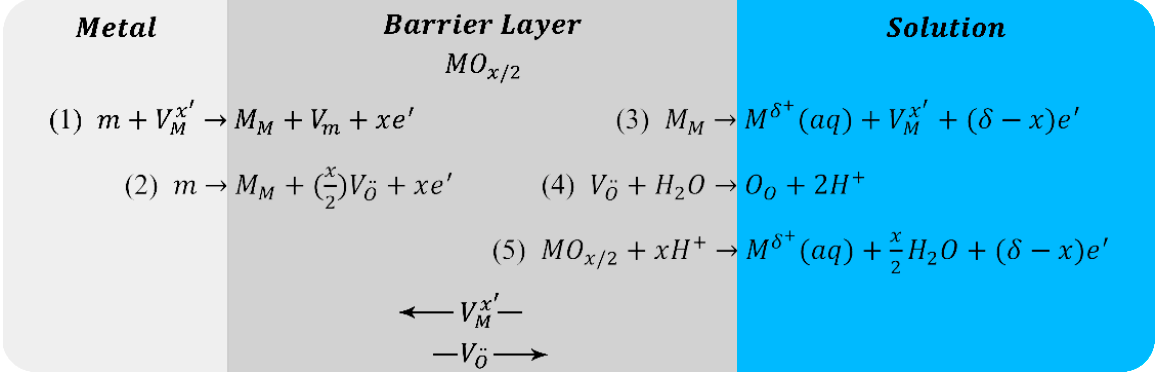
Figure 12. Physicochemical processes scheme in the PDM: m is metal atom, V x' M M is metal cation in cation site, V m is vacancy in metal phase, e ′ is electron, V .. vacancy, M (cid:2012) + ( aq) is cation in layer/solution interface, O O is oxide ion in anion site, MO x/ 2 is stoichio- metric barrier layer.